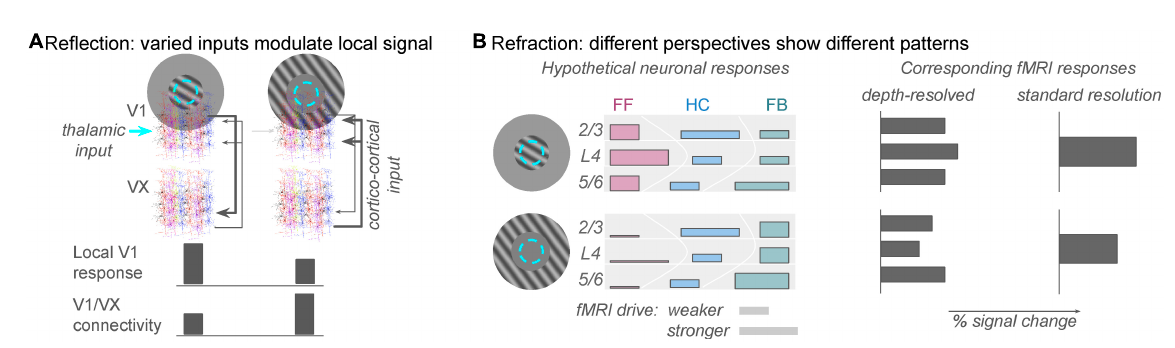
FIGURE2 The analogies of reflection and refraction are helpful for framing population responses in V1 as a function of spatial context. (A) Reflection: feed-forward receptive fields in V1 are determined by thalamic inputs to the brain (cyan circle: population receptive field location), but the local V1 fMRI response can also reflect strong drive from cortical sources (gray arrows from extrastriate regions, VX). The reflection analogy refers to the fact that this non-zero fMRI response is reflecting figure/ground segmentation computations from other regions in the brain. This allows the local V1 population to perform an important comparison between new sensory information and expected scene configuration. Task-dependent connectivity analyses will discover that correlations between unmodeled fluctuations in the V1 signal and extrastriate (VX) signals are strong during the second condition. (B) Refraction: different analyses will show different patterns of response, but one does not invalidate the other. On the left, colored bars indicate rough predictions of responses in a population receptive field (cyan dashed circle) to stimuli that invoke different levels of feedforward